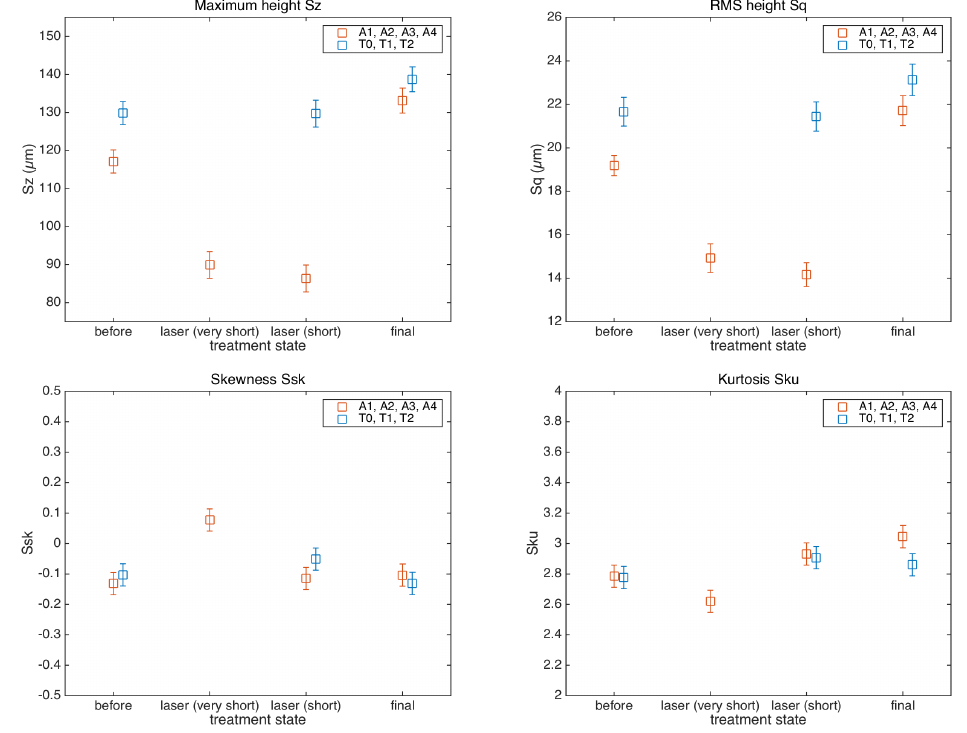
Figure 6. Amplitude roughness parameters of the painting surface at the different processing steps: before the treatment, intermediate (laser), and final (laser+chemical). The plot combines the results of the experiments in the azurite (blue markers) and red lake (red markers), with the cleaning treatments applied in multiple and single ROI (see Table 1).